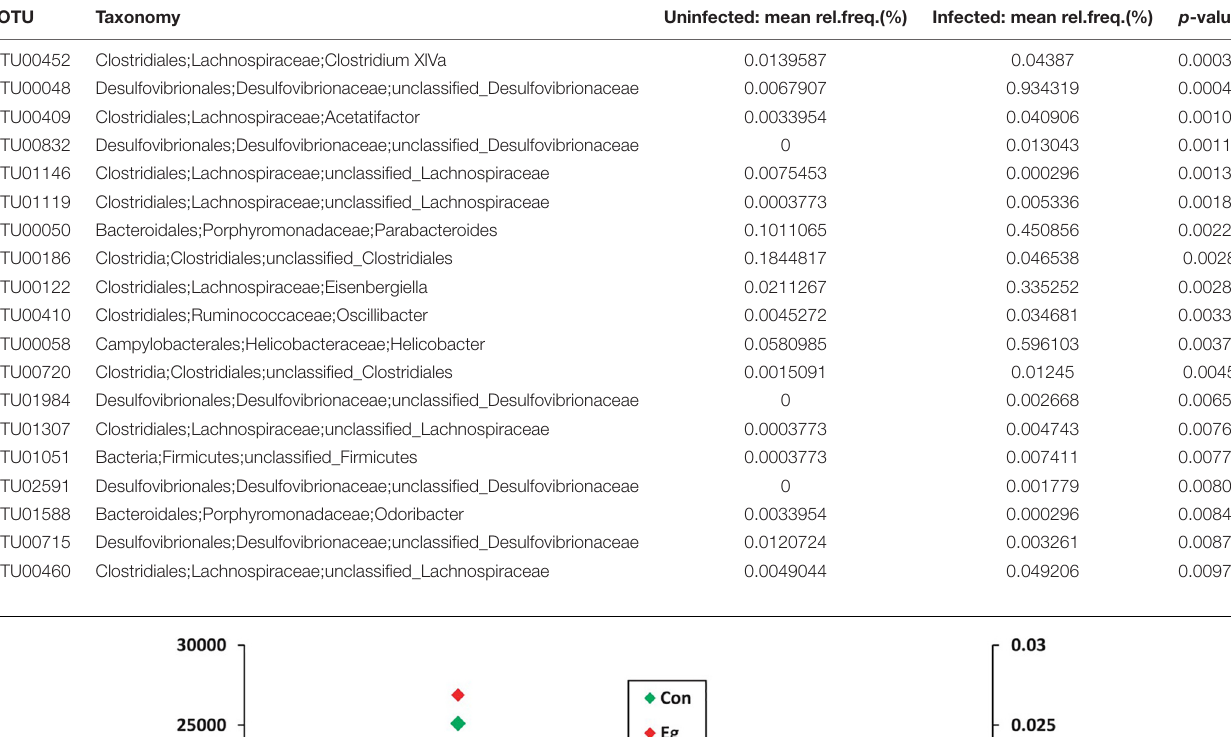
TABLE 5 | The abundance of OTU ( p < 0.01) in the infected mice and uninfected mice determined by LEfSe analysis. #OTU Taxonomy Uninfected: mean rel.freq.(%) Infected: mean rel.freq.(%) p -values